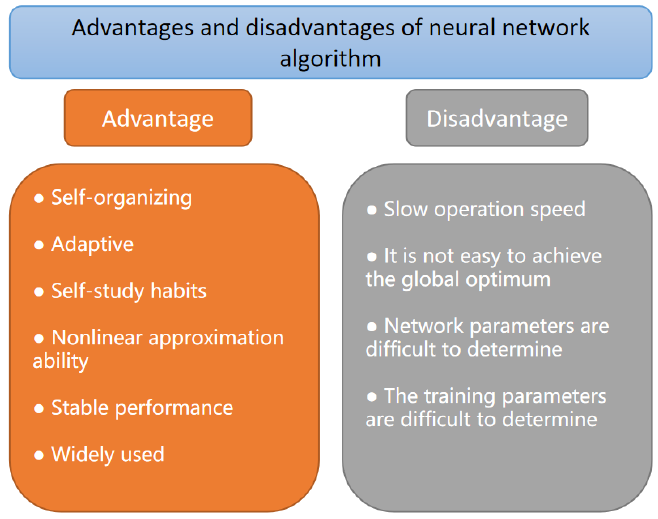
Figure 3. Comparison of advantages and disadvantages of neural network algorithms.